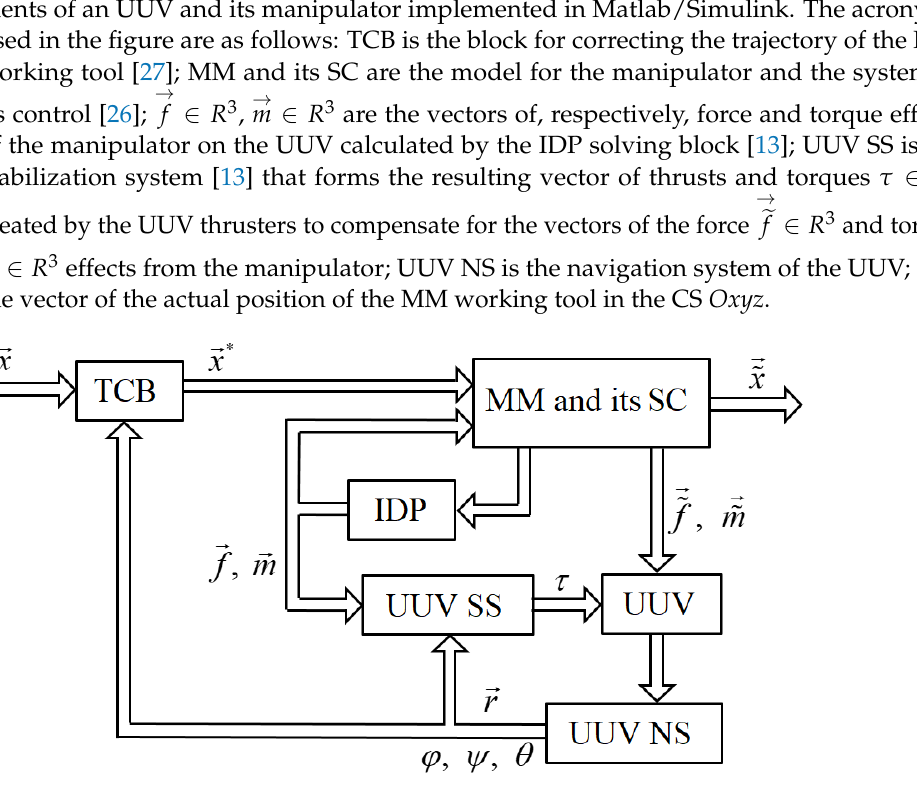
Figure 8. Block diagram of the subsystem for the dynamic control of UUV and its manipulator.